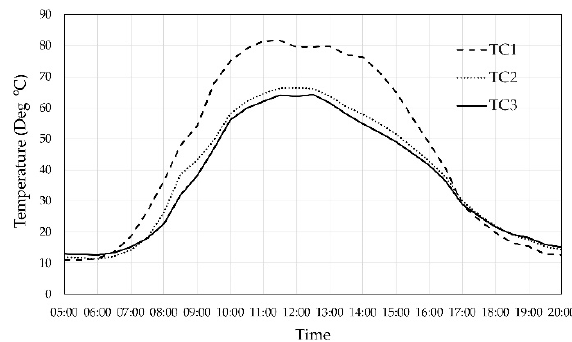
Figure 9. Irradiance and mass flow rate of brine and product of the MSS prototype ‐ 1 for one day of operation (Apr 1st).